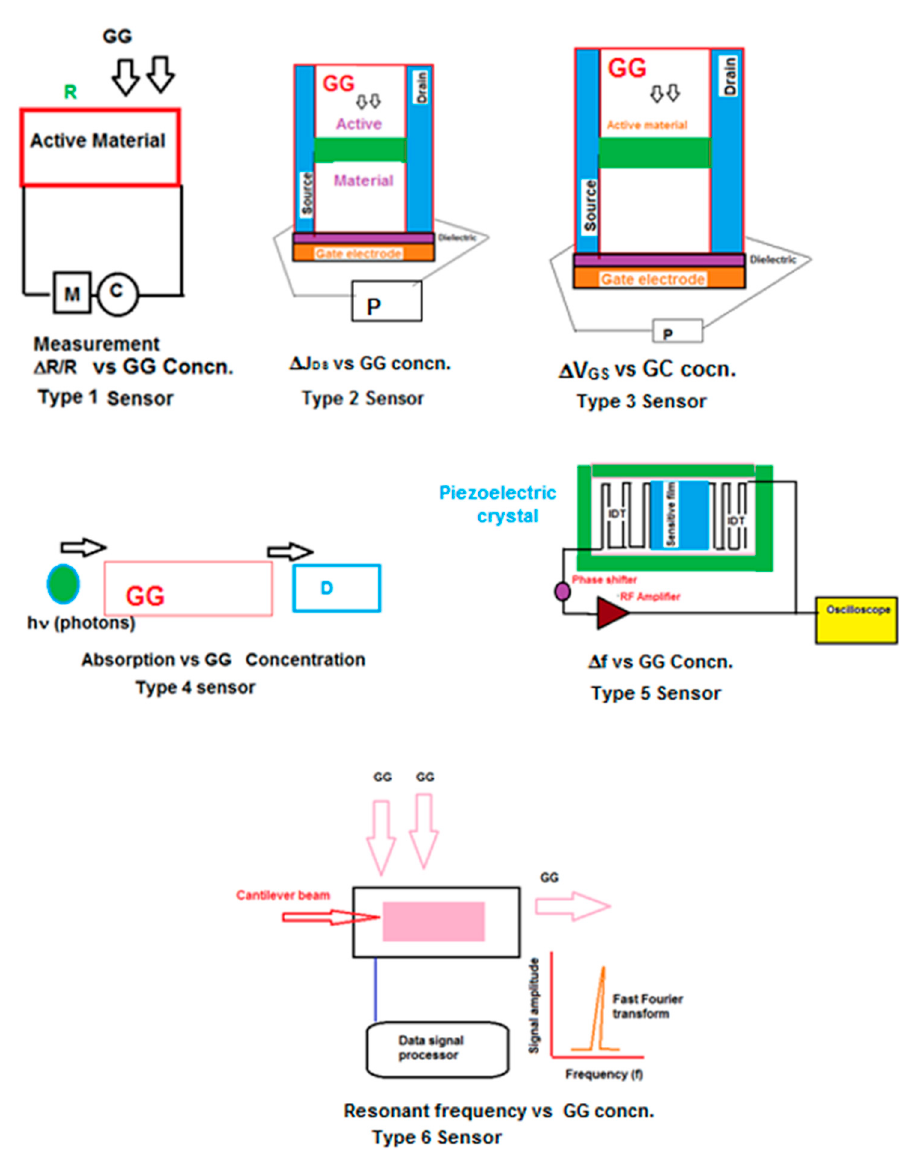
Figure 4. Types of sensors developed for greenhouse gas measurements. M: digital multimeter; C: computer with software for monitoring the measuring multimeter; P: potentiostat (monitors the field effect transistor parameters); D: detector (e.g., photomultiplier or bolometer); GG: greenhouse gas; IDT: inter digitized electrode.